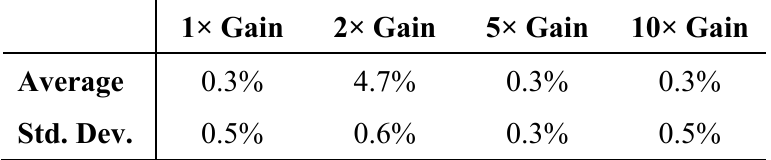
Table 1. Percentage difference between the results from the PXIe-6124 measurements and the Underwater Sound Recorder measurements for the whale call waveform.